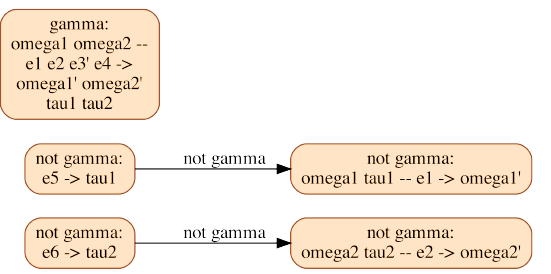
Figure 11. CDG resulting from the multimode structural analysis of the Clutch